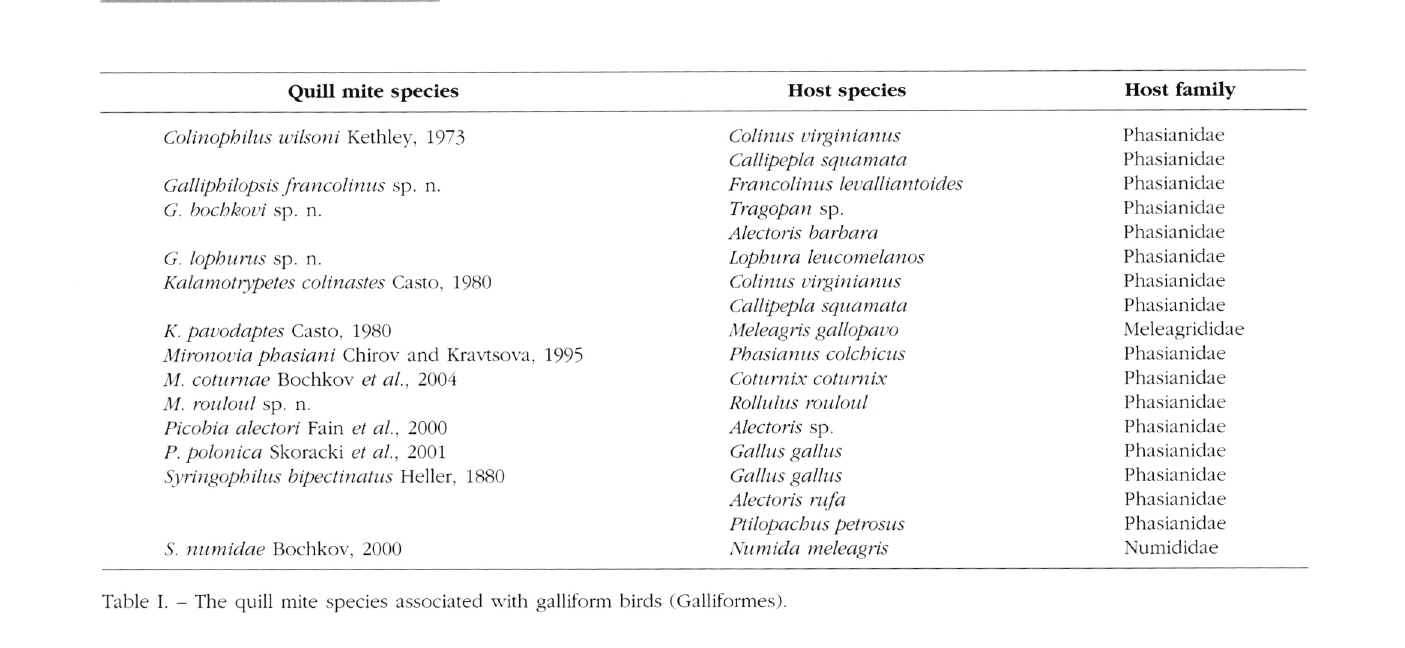
Table I. - The quill mite species associated with galliform birds (Galliformes).